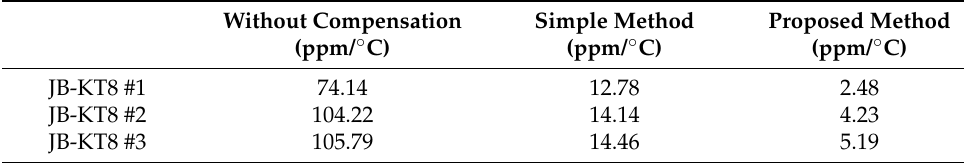
Table 4. Compensation of temperature sensitivity of scale factors.